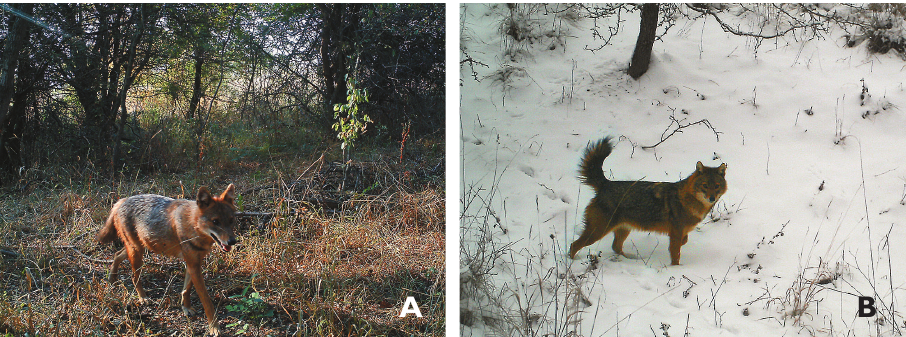
A B Figure 2. Photographs of a golden jackal ( Canis aureus ) individual in the summer ( A ) and winter ( B ).